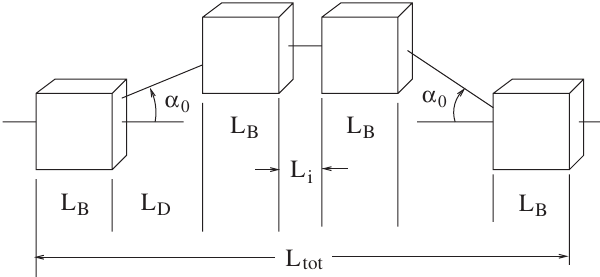
FIG. 10. An updated (for low electron energy) standard chi- cane. Comparisons between UAL and CSRTRACK simulation codes are based on this standard. Chicane parameters are given in Table II and electron beam parameters are given in Table III.